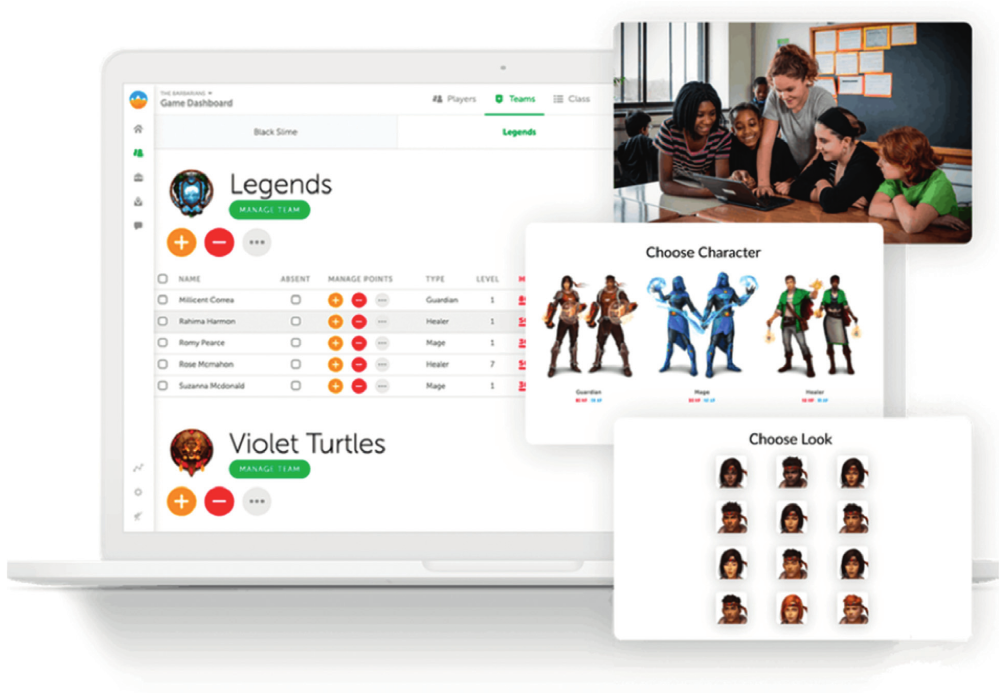
Figure 1: A screenshot of gamification designs in Classcraft